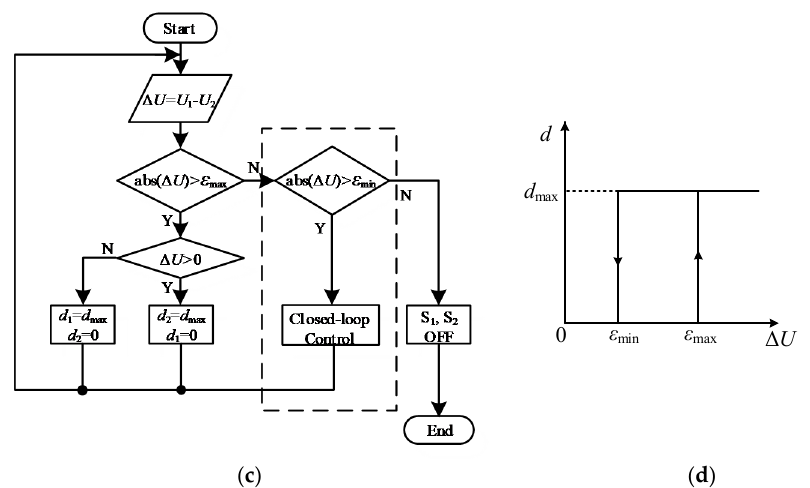
Figure 6. A unified control strategy for inductor ‐ based equalisation topologies. ( a ) Closed ‐ loop control strategy; ( b ) triangle carrier of the switches; ( c ) control flow chart; and ( d ) common control strategy.